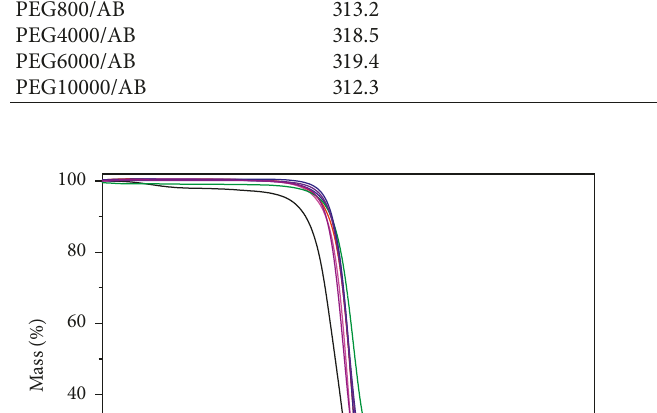
Table 1: Relative weight changes of the PEG/AB composites before and after the leakage tests at 80˚C for 1.5h. Samples Average weight before (mg) Average weight after (mg)